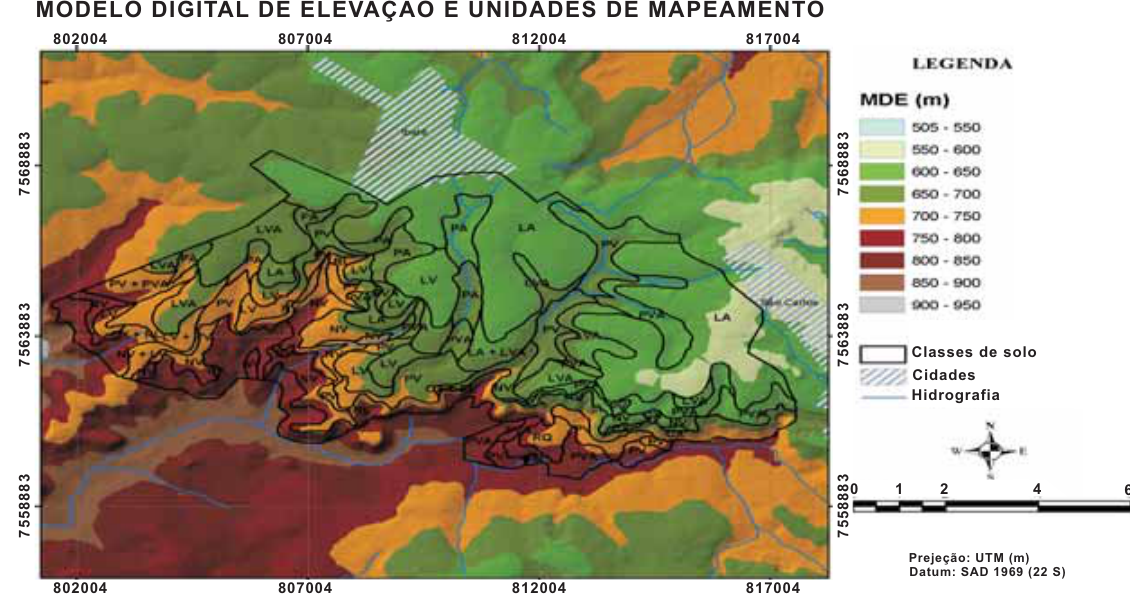
Figura 1. Mapa de solos semidetalhado, elaborado pelo método tradicional de campo, na referida área de estudo e o modelo digital de elevação